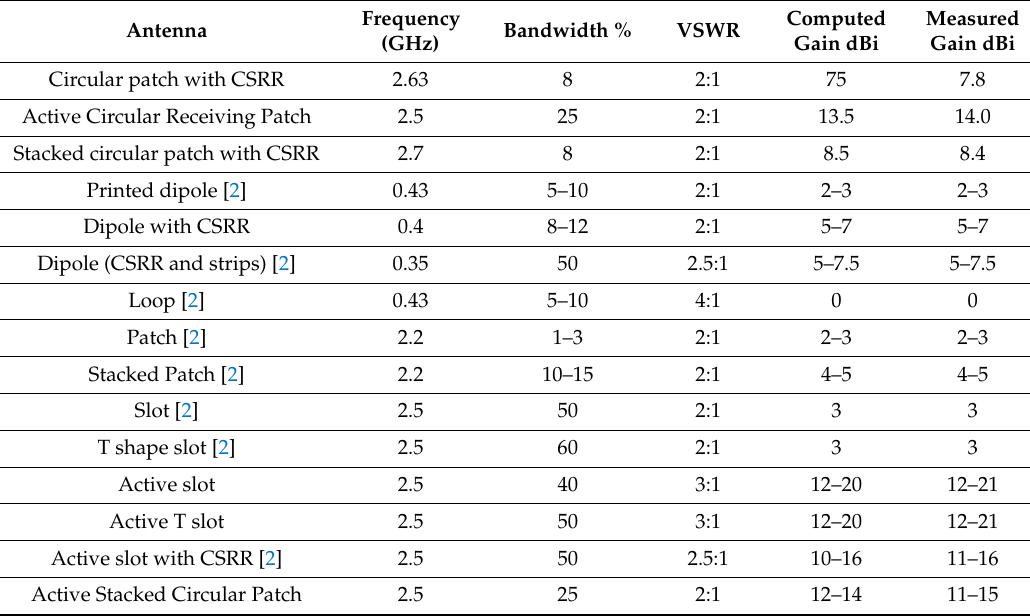
Table 7. Comparison of electrical characteristics of wearable antennas